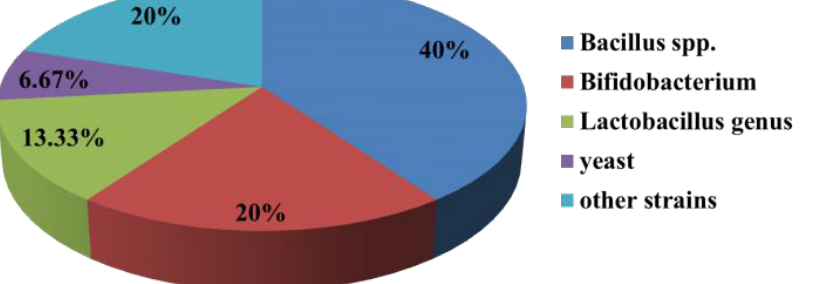
Figure 1. Percentages of different antagonistic microbes of C. albicans